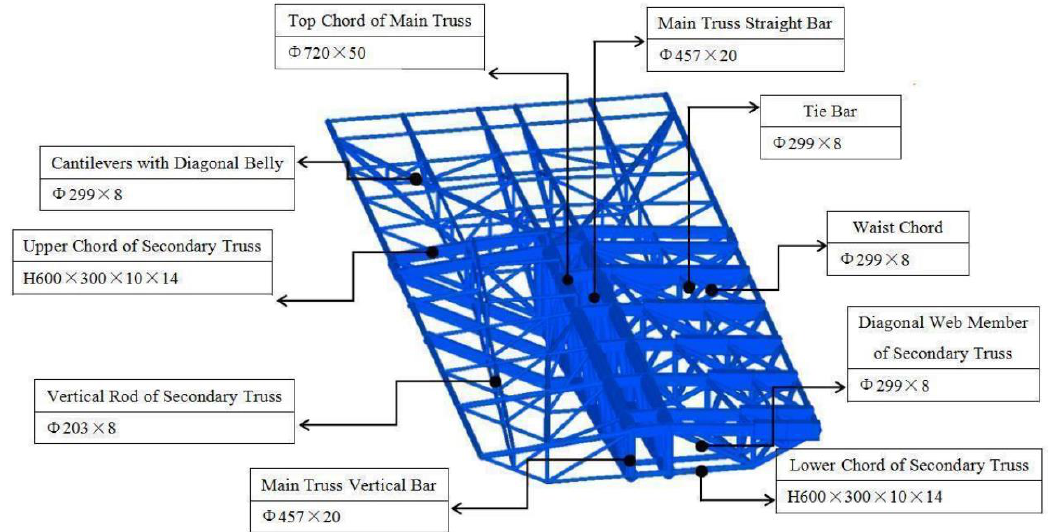
Figure 2. Model of the typical steel truss structure.